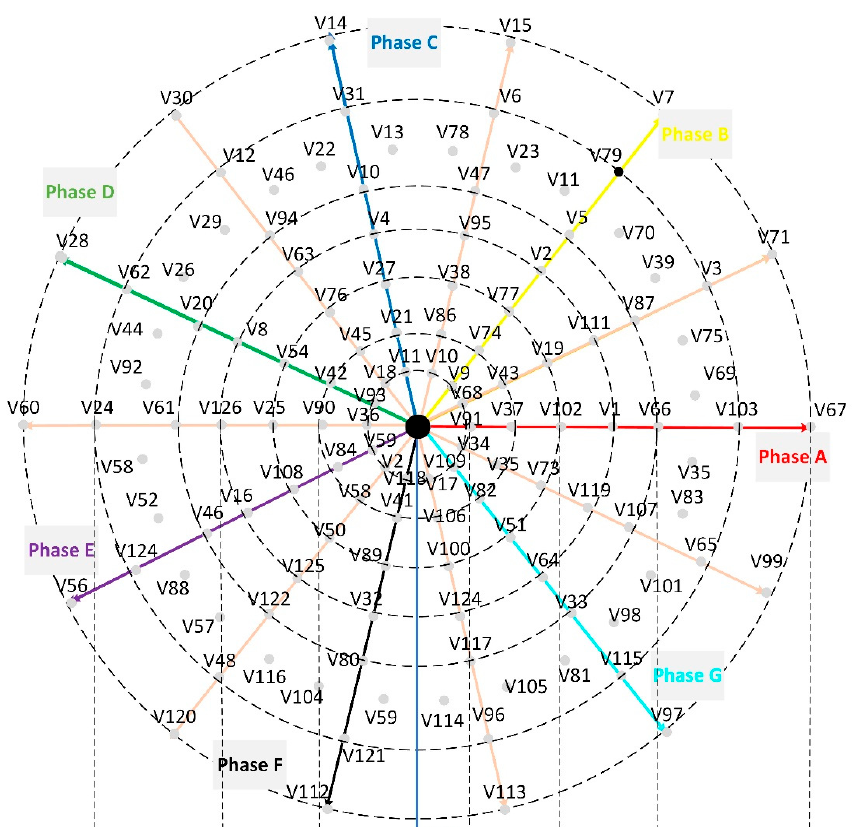
Figure 2. Voltage vector space distribution in the x1 ‐ y1 plane [38].